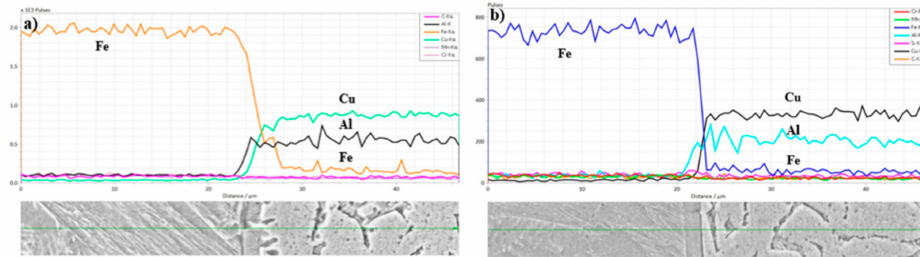
Figure 7. Line scan in GMA welds: ( a ) brazing low heat input and ( b ) brazing high heat